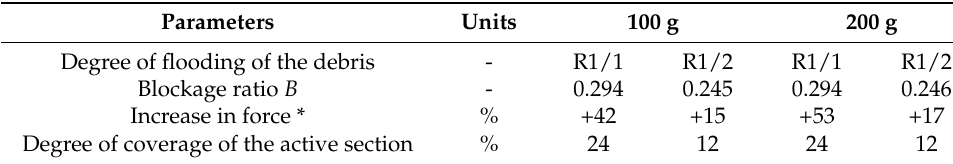
Table 2. Geometric parameters of debris.